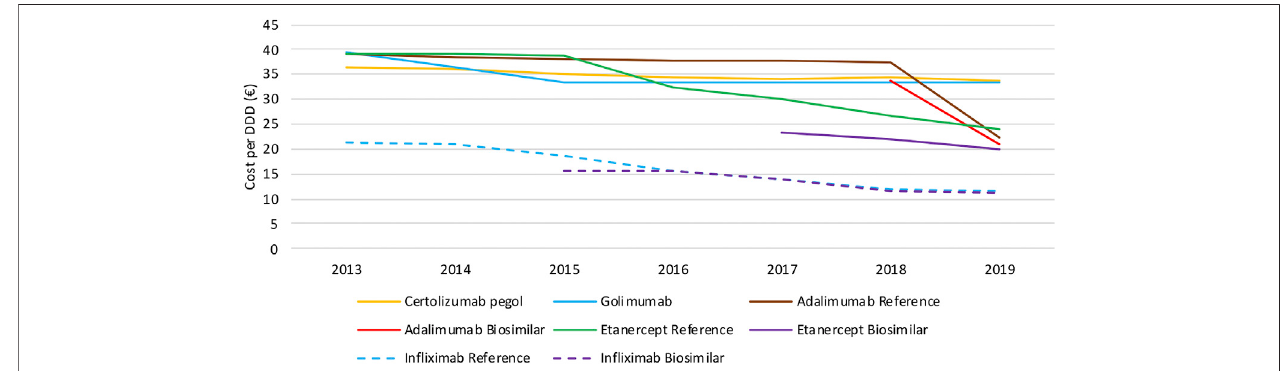
FIGURE 4 | Daily cost ( € per DDD) evolution of TNF inhibitors between 2013 and